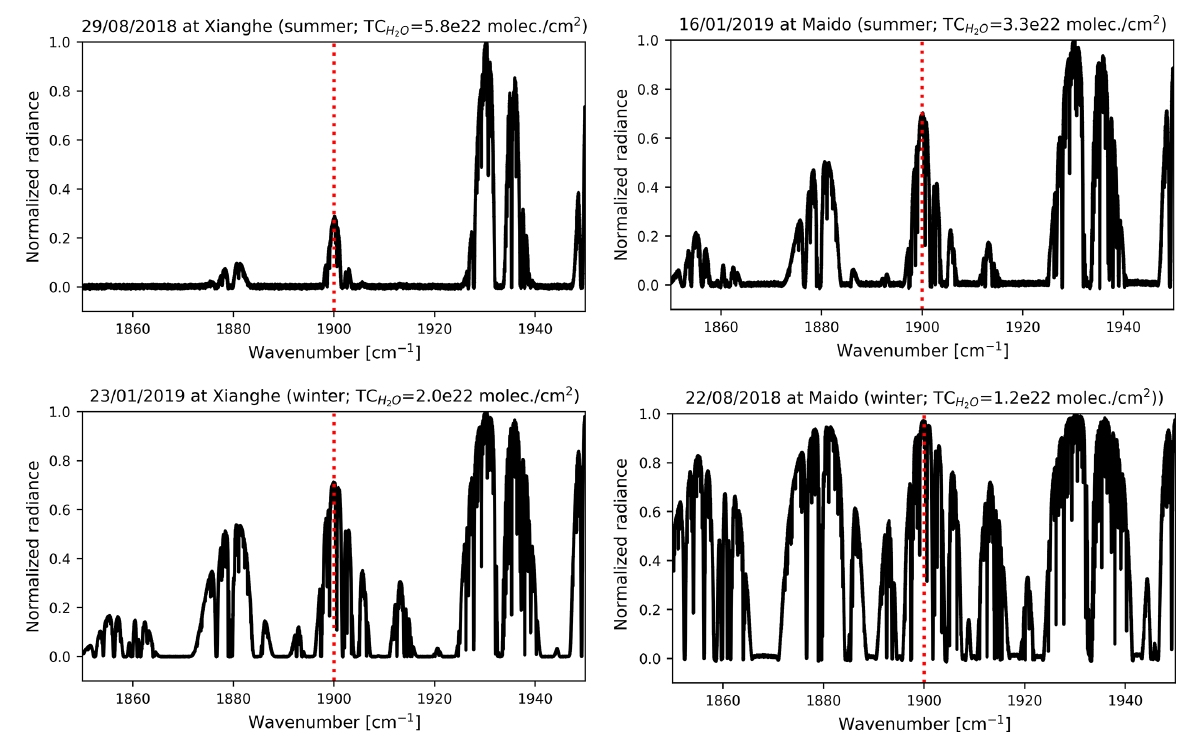
Figure 2. The normalized spectra in summer and winter at Xianghe and Maïdo, together with the total column of water vapor on these days. The dashed red line indicates the retrieval window for